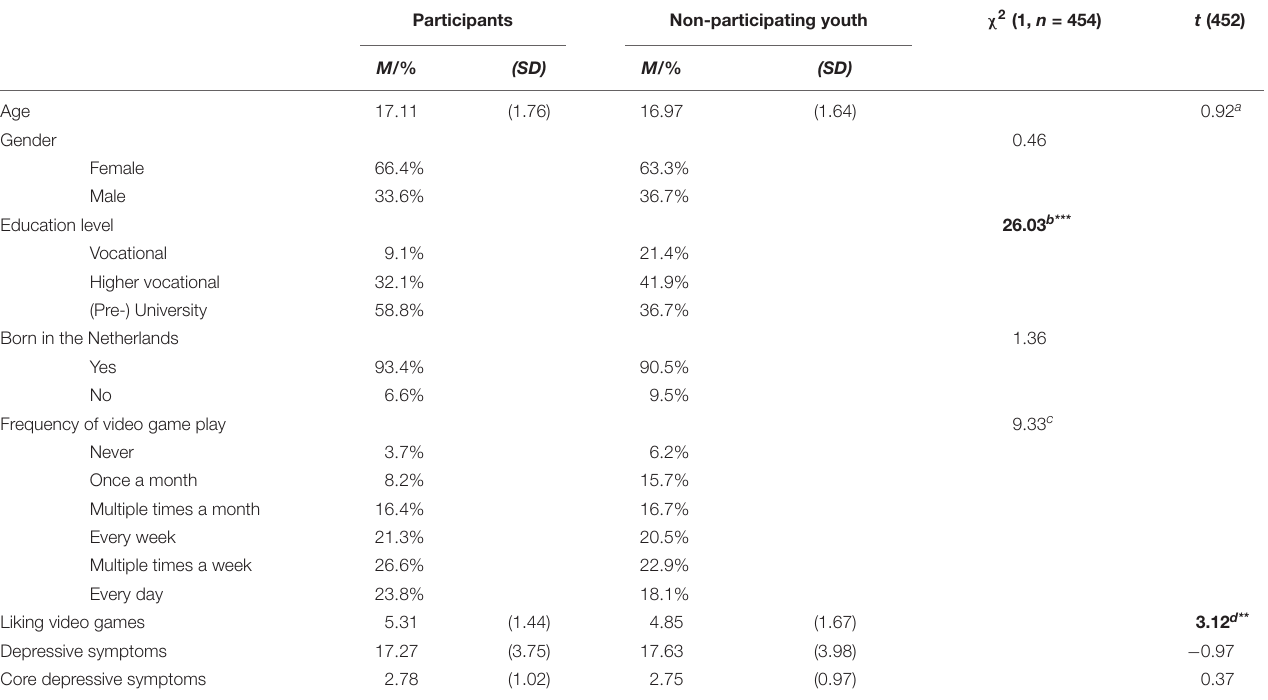
TABLE 1 | Descriptives (Means and Standard Deviations or Percentages) and χ 2 or F -values of demographic variables for participating and non-participating youth